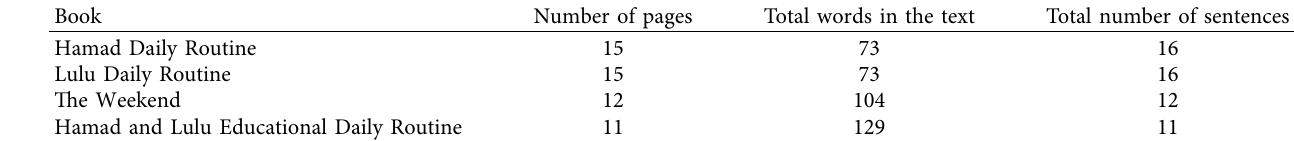
Table 1: Characteristics of